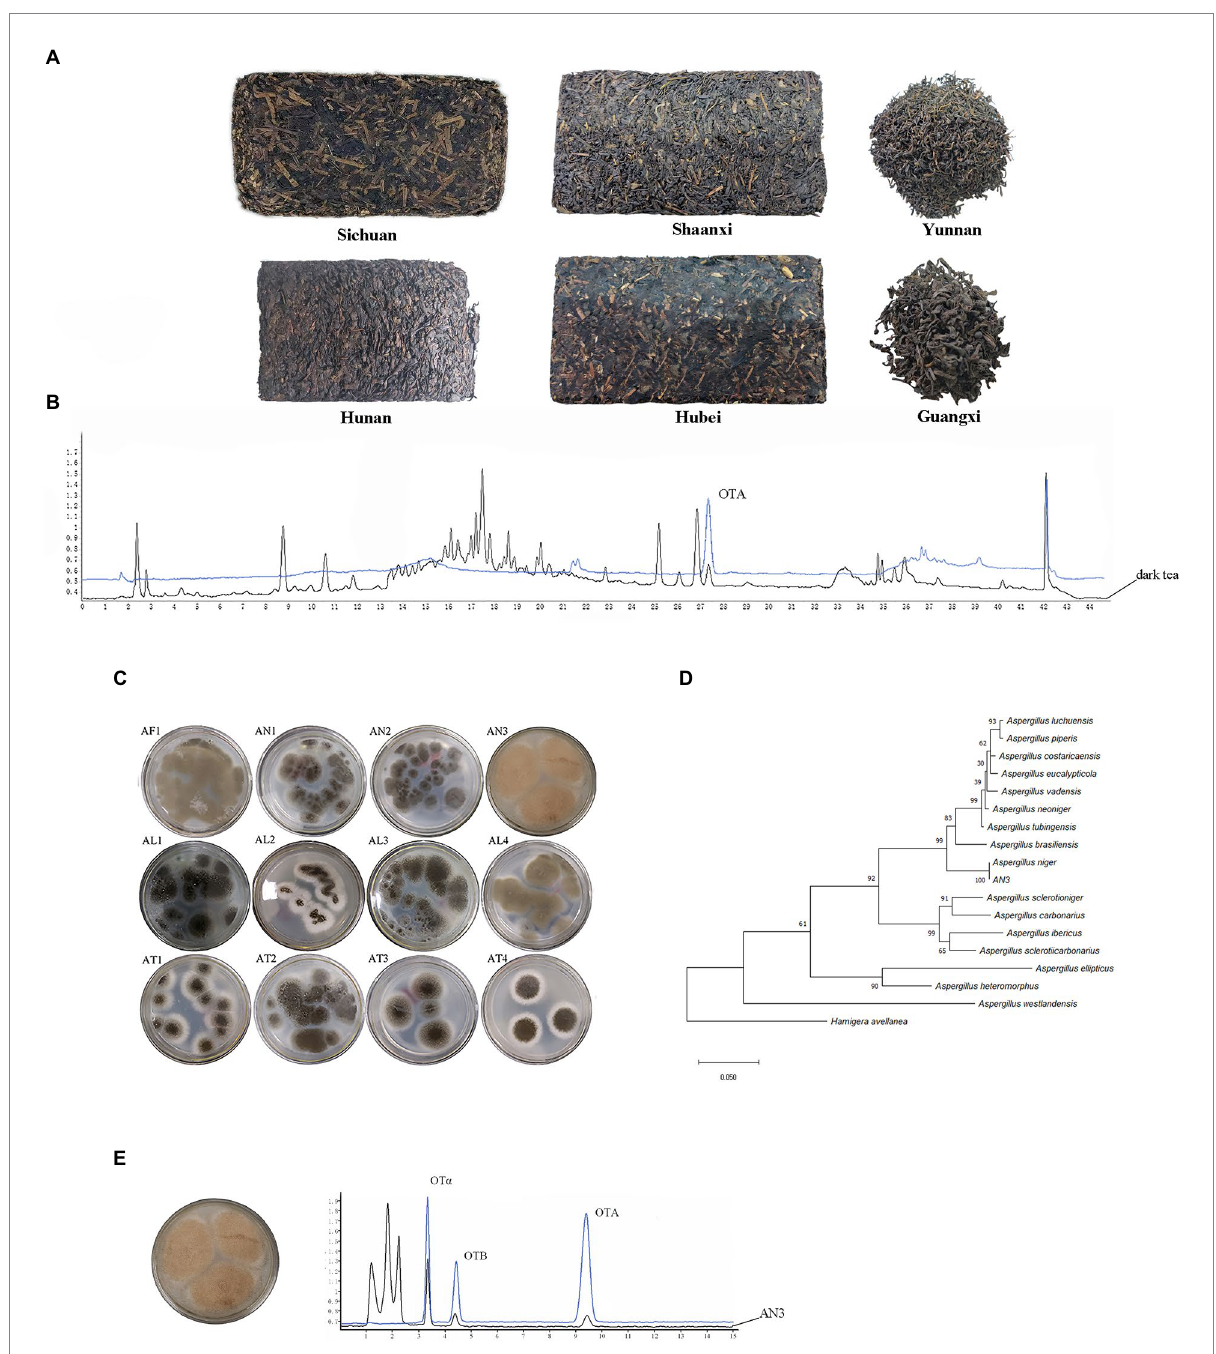
FIGURE 2 OTA detection in dark tea samples and isolation of OTA-producing fungal strains. (A) Tea samples from six different regions. (B) Chromatograms of OTA in dark tea sample. (C) Aspergillus fungal strains isolated from tea samples containing OTA. (D) Phylogenetic tree of A. niger AN3 based on combined sequences of BenA , CaM , and RPB2 gene. (E) OTA-producing fungi, A. niger AN3 and Chromatograms of OTA-producing